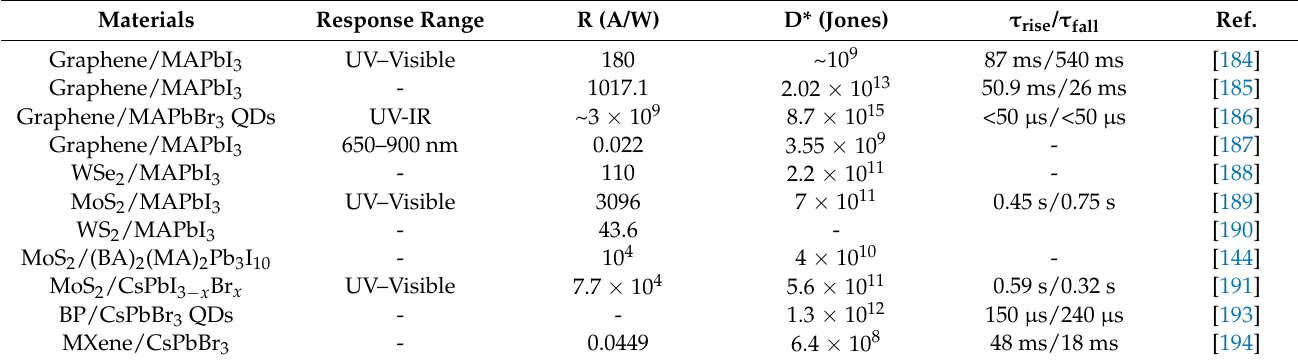
Table 6. Summarized device performance of photodetectors in Section